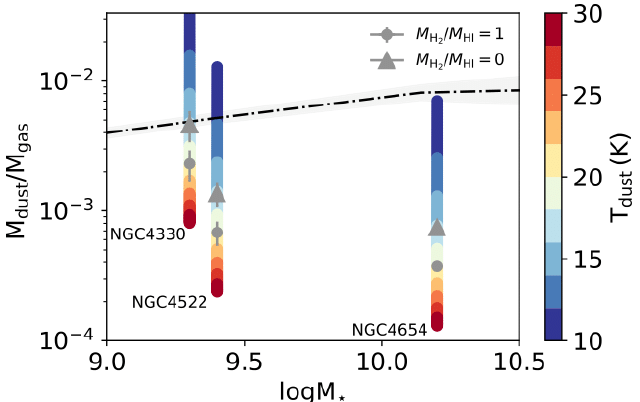
Figure 8. The dot-dashed line shows the dust-to-gas mass ratio vs. galactic mass measured in Virgo galaxies by Cortese et al. [181]. Credit: Longobardi et al. [164]. A&A, 644, A161, 2020, reproduced with permission ©